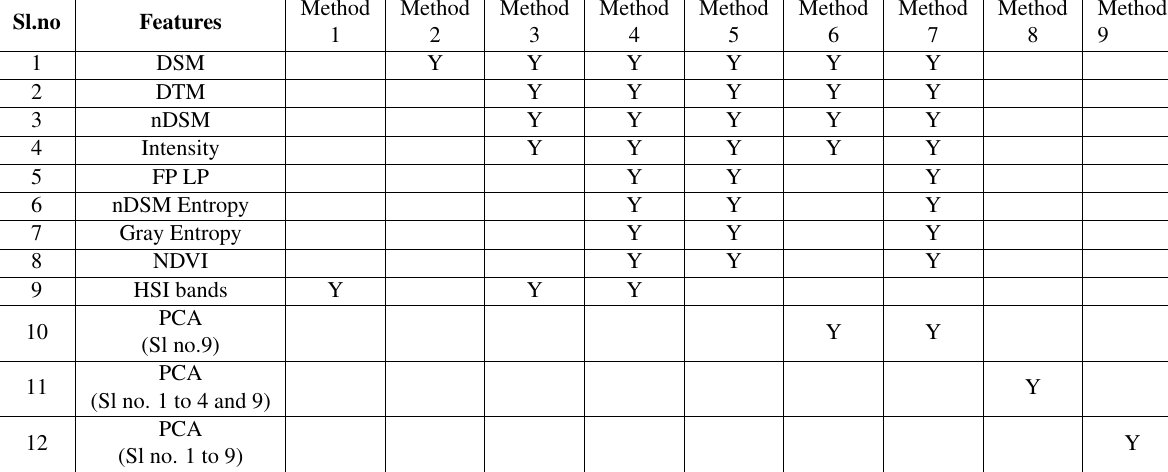
Table 4. Relationship between features and different methods. ‘Y’ means that a particular feature is used by a method. Sl.no